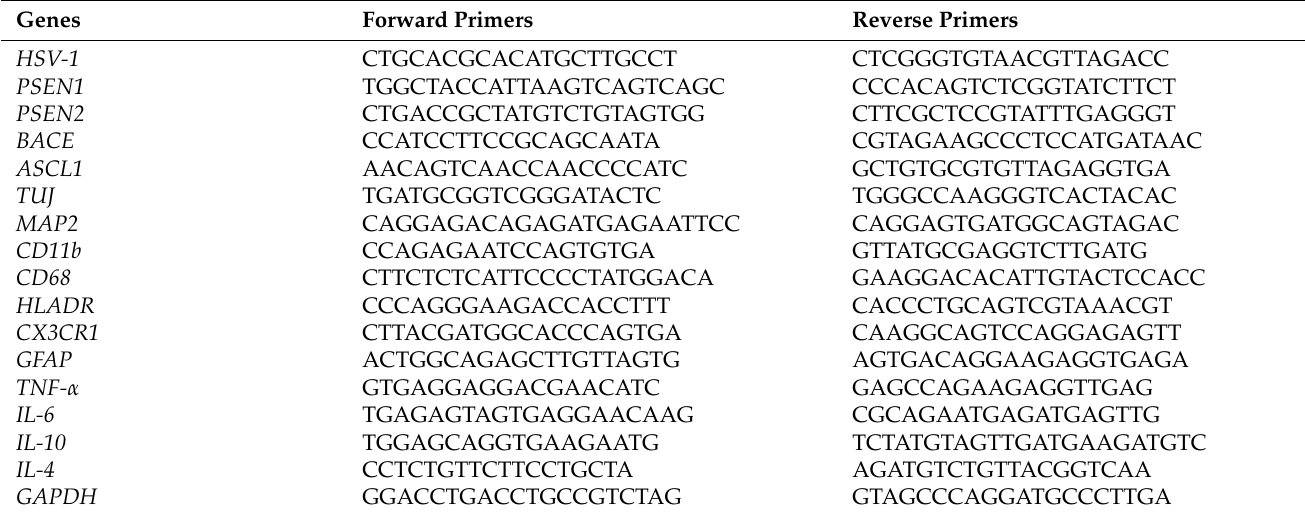
Table 3. Primer sequences used for